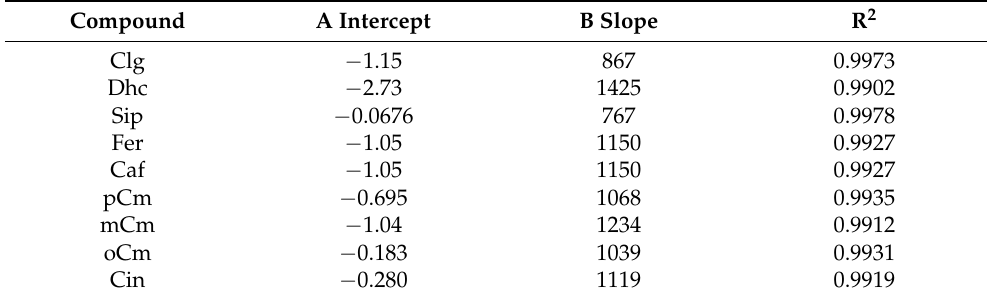
Table 2. Coefficients A and B with correlation coefficients (R 2 ) for plots based on the van’t Hoff equation: lnk = A + B(1/T), shown in Figure S1 for Tween 20.